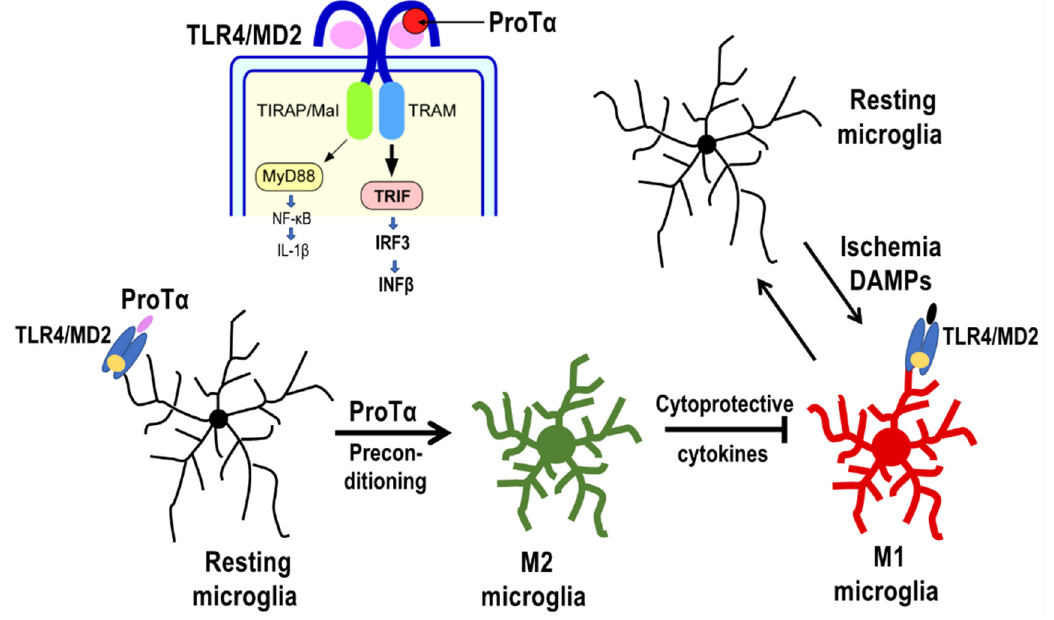
Figure 3. ProT α drives resting microglia into M2 microglia. ProT α drives the TLR4/MD2 ‐ mediated Toll–IL ‐ 1 receptor domain ‐ containing adaptor inducing IFN ‐β (TRIF) system. ProT α drives resting microglia into M2 microglia, which show an alternative activation through the production of cyto ‐ protective cytokines and deactivation of M1 microglia, which are induced by ischemia ‐ related dam ‐ age ‐ associated molecular patterns (DAMPs)/cytotoxic cytokines.